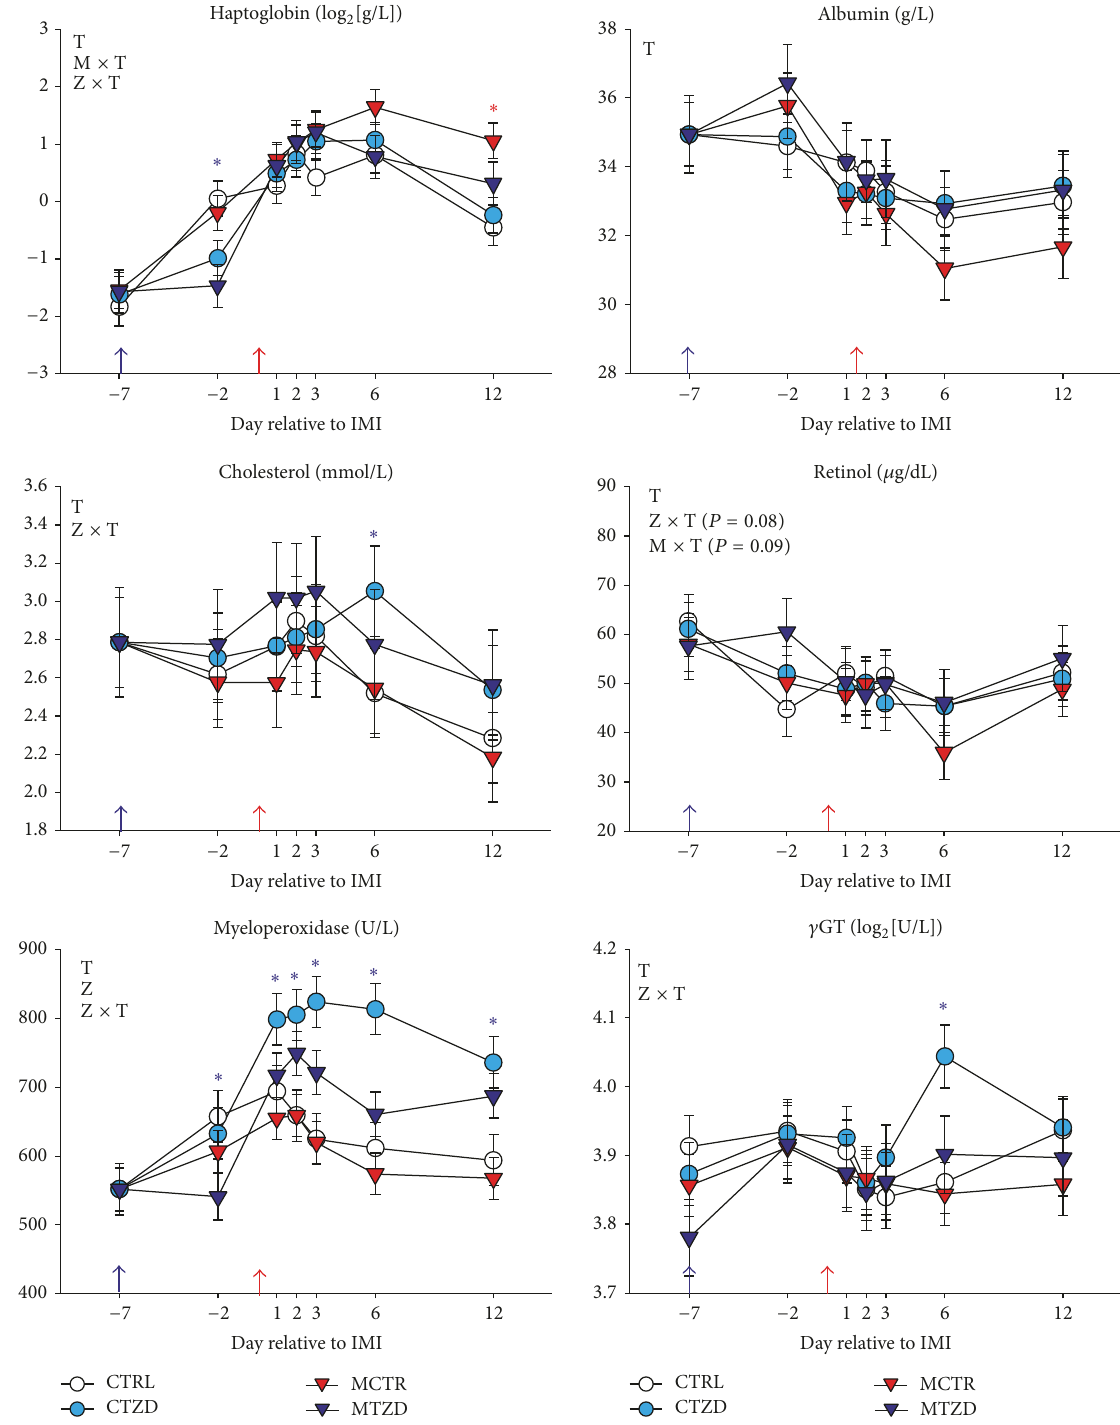
Figure 7: Plasma concentration of blood inflammatory markers and liver stress, including the positive acute phase protein haptoglobin, the markers of negative acute phase albumin, total cholesterol, and retinol, the neutrophils killing capacity marker myeloperoxidase, and the marker of liver stress/disease gamma-glutamyl transferase ( 𝛾 GT) from − 7 to 12d of Strep. uberis (M) or saline intramammary infusion (IMI) in goats receiving daily intrajugular injection of 2,4-thiazolidinedione (TZD) or saline (CTR). Significant ( 𝑃 ≤ 0.05 ) effects and interactions are indicated in the graph (mastitis: M, time: T, and TZD: Z). The 𝑃 value for tendency is reported. Significant effect of M × T is denoted with red asterisk and effect of Z × T is denoted with purple